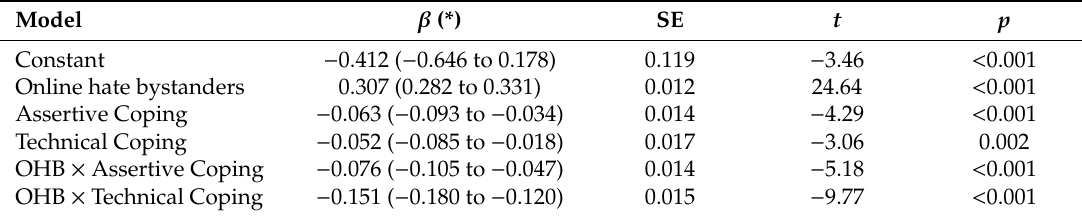
Table 5. Coefficients of the model predicting online hate perpetration. Table 5. Coe ffi cients of the model predicting online hate perpetration.